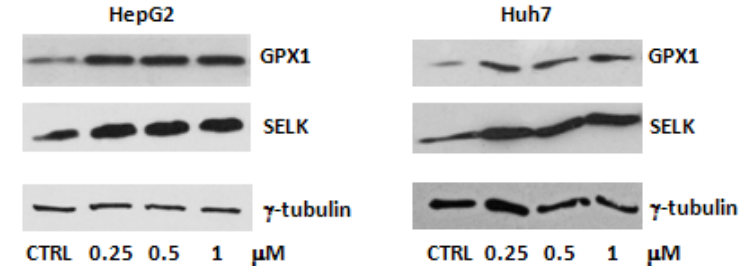
Figure 3. Difference score (Diff.score) between hepatocytes and HepG2